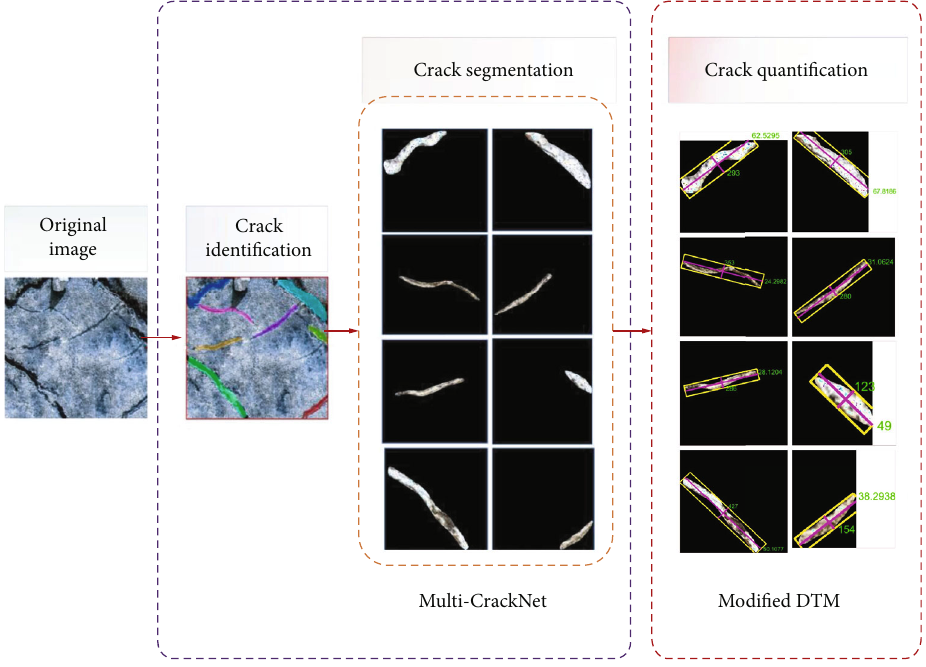
Figure 4: Overview of the hybrid multicrack identi fi cation and quanti fi cation